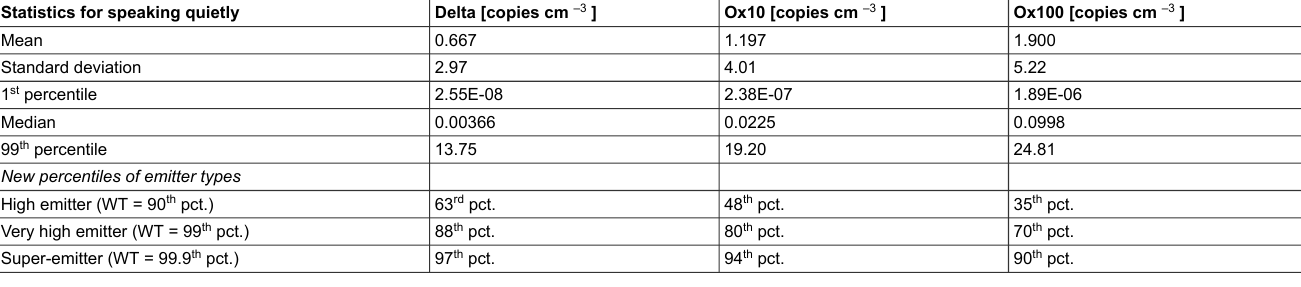
Table 1: Descriptive statistics of viral emissions in the PM 10 -sized fraction with quiet speaking for published viral load data for Delta and for two viral load estimates for Omicron (Ox10 and Ox100). For the predefined emitter types, the percentile (pct.) in the WT distribution and the new percentiles are shown. Statistics for speaking